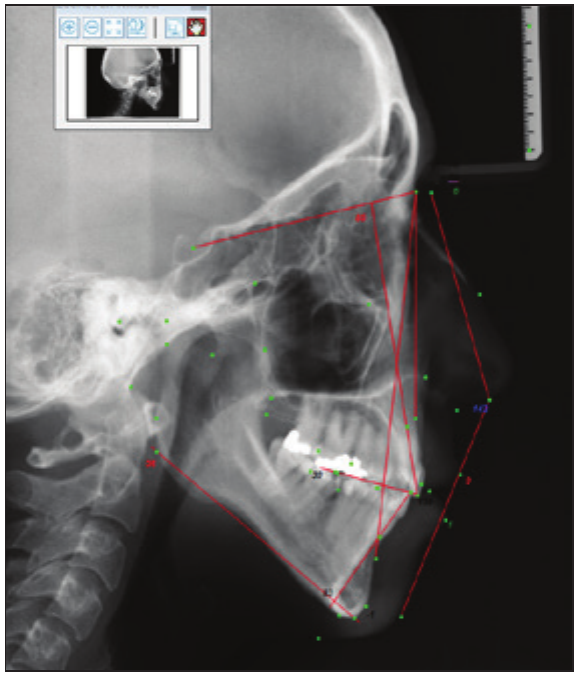
Figure 14. Posteroanterior radiograph of the patient after 10 years follow-up.